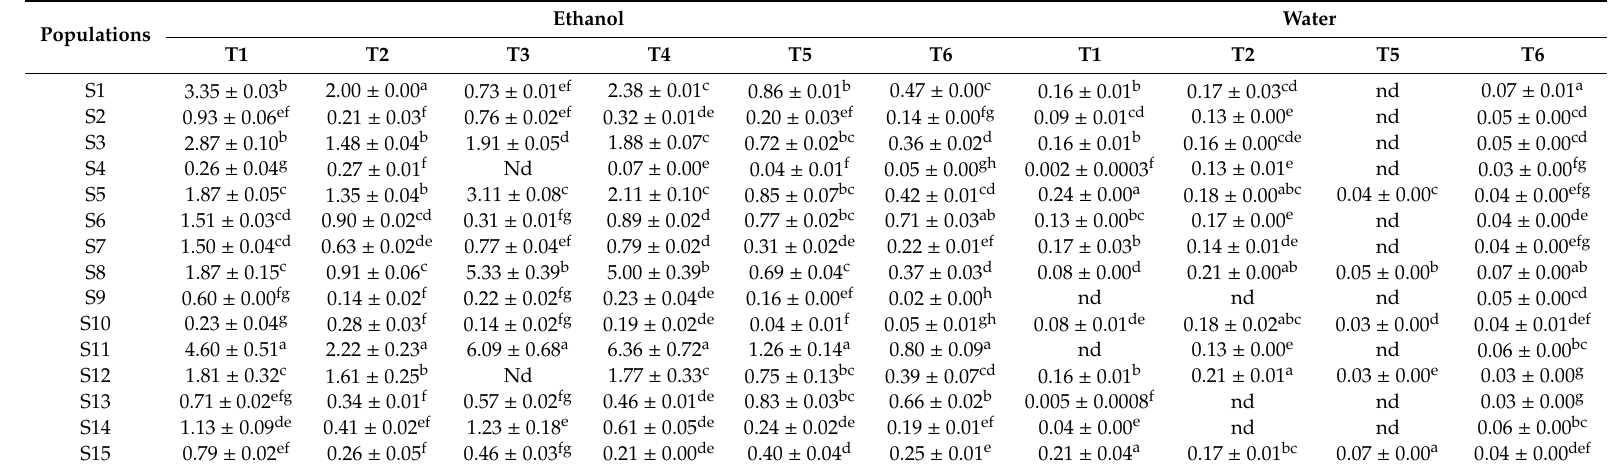
Table 3. The content (mg / g) of individual triterpenoid in ethanol and water extracts of C. paliurus